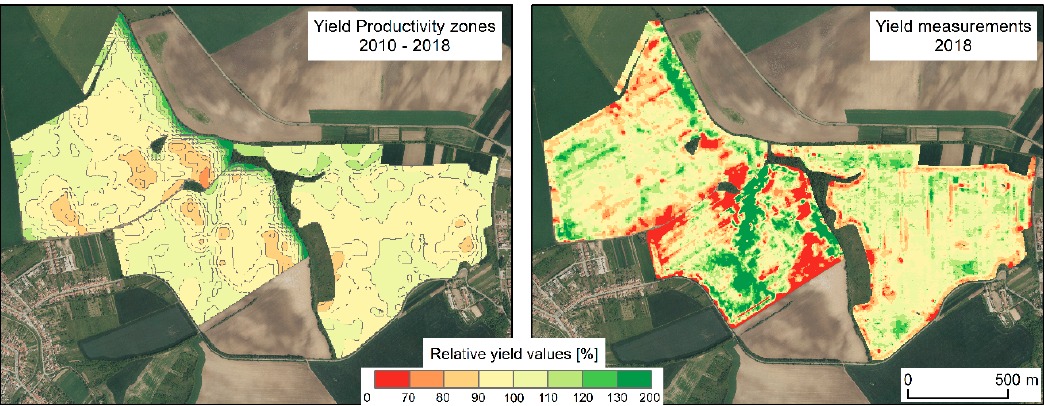
Figure 3. Input data used for the analysis of yield productivity zones: yield productivity zone prediction derived from satellite images ( left ) and the map of yield measurements as computed by a harvester ( right ).